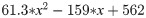
Mean reaction times for far disparity values at two contrast levels (10% and 90%).Each data point represents the mean of 15 participants (at least 141 RTs); error bars show ±SEM. Asterisk marks significant difference (p<0.05) found in pairwise comparisons between the lowest disparity and disparity with the shortest mean RT at both contrast. The mean RTs for near disparities (from Fig 2) are superimposed for comparison by gray lines. Second order polynomial fits are represented by solid black curves (R2 = 0.592, min. value = 19.8 arc min, equation = 61.3*x2-159*x+562 for 10% and R2 = 0.422, min. value = 19 arc min, equation = 28.8*x2-74*x+405 for 90% contrast).